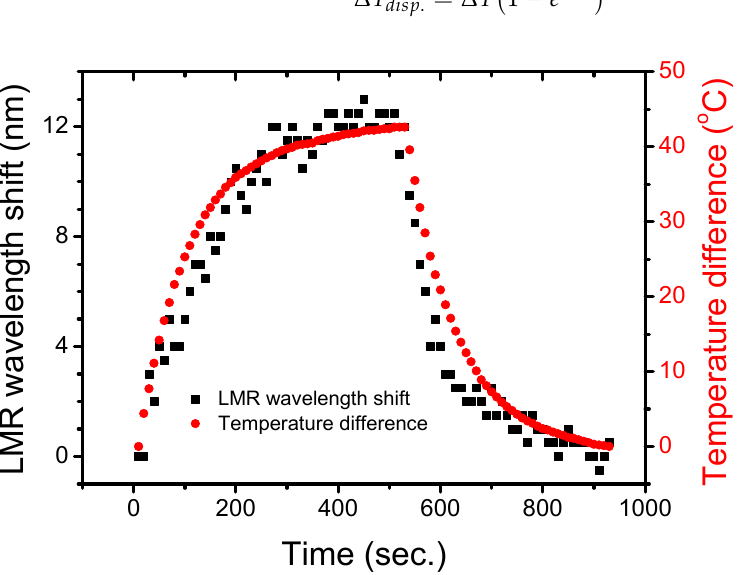
Figure 8. Shift in the LMR wavelength and temperature difference for the heating and heat dissipation of glycerol, where the red circles and the black squares represent the respective experimental data of temperature difference and LMR wavelength shift.